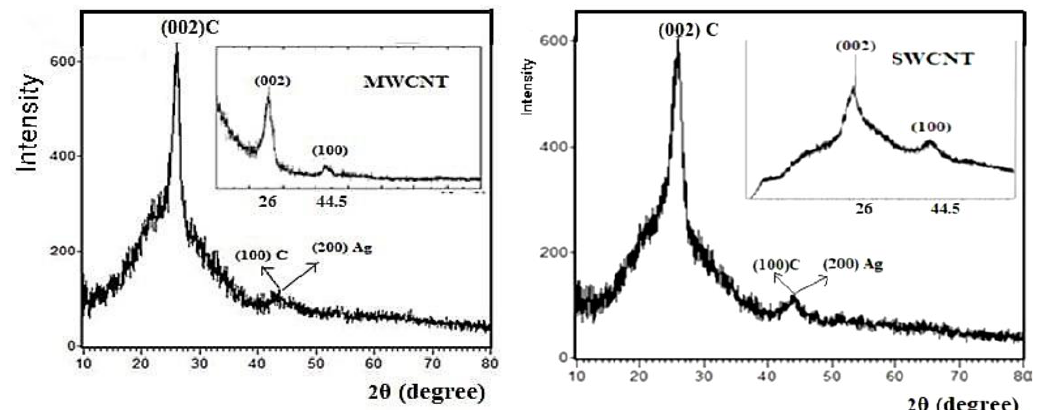
Figure 7b: XRD patterns (right) for SWCNTs/Ag NPs (left) for MWCNTs/Ag NPs thin